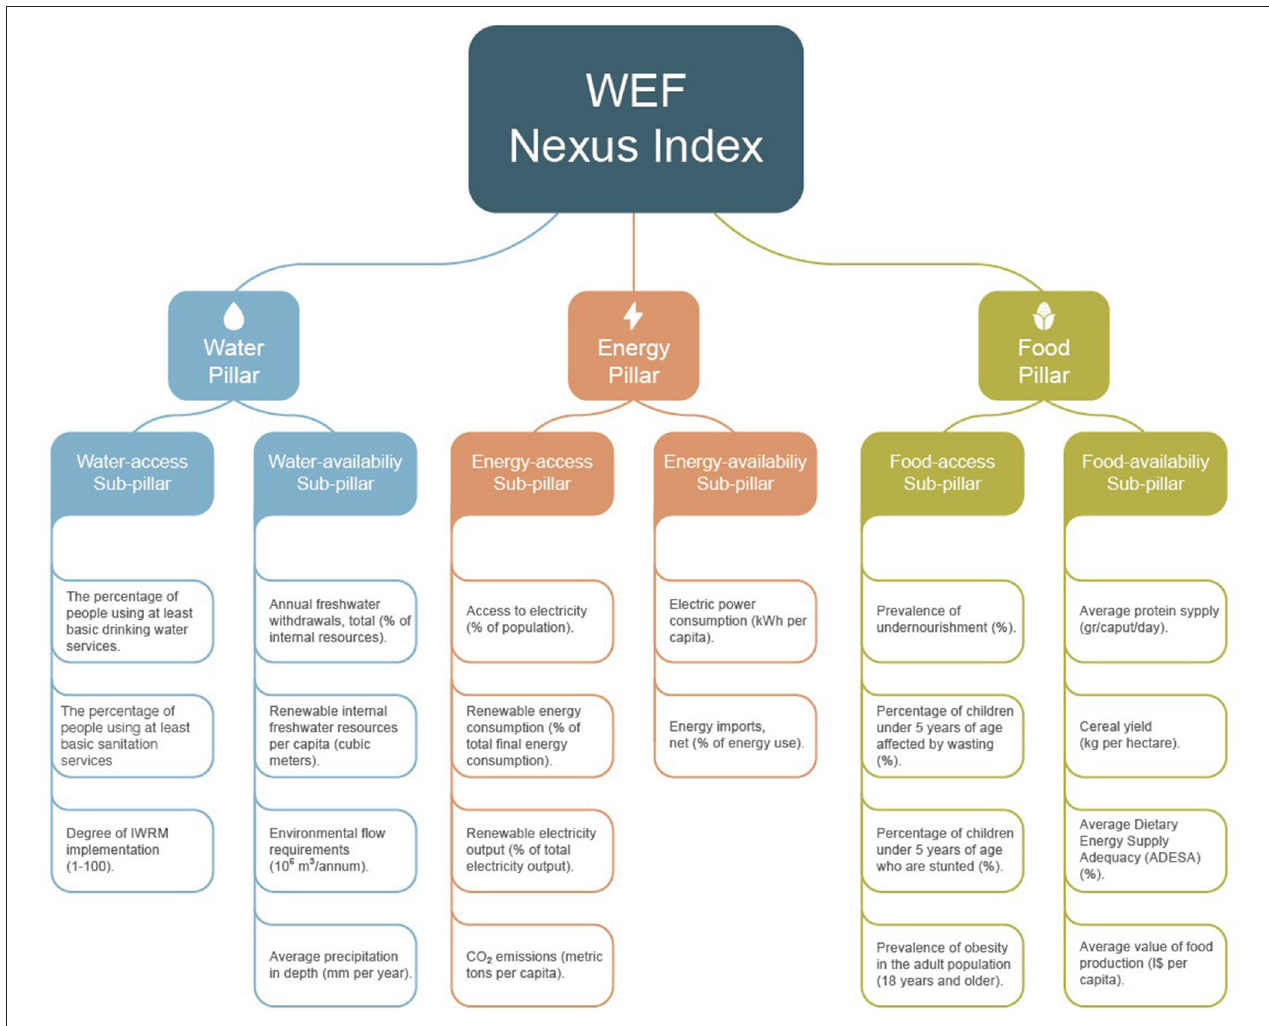
FIGURE 3 | Schematic layout of the WEF Nexus Index, with its constituent pillars, sub-pillars, and indicators.